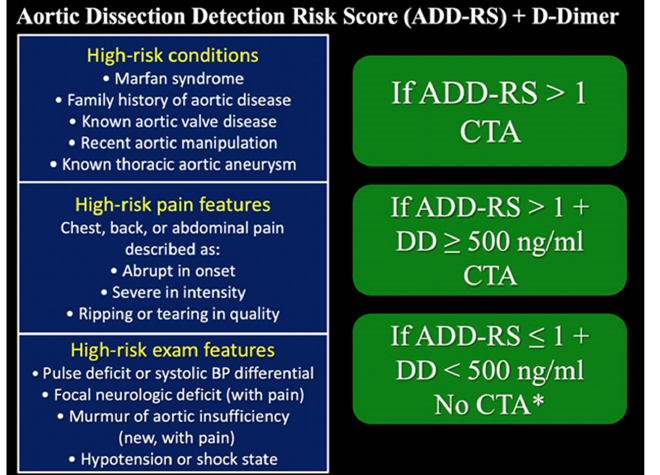
Figure 4. Pretest clinical probability assessment according to Aortic Dissection Detection Risk Score (ADD-RS) and D-Dimer (DD). ADD-RS score is based on 12 risk factors organized in three categories (0, low risk; 1, intermediate risk; 2-3. high risk). BP = blood pressure. *Caution in patients with early presentation ( ≤ 2 h) or long-lasting symptoms ( ≥ 1 week) [28]. Table 3. Complete list of morphologic features in AAS that need to be covered by imaging. The Ten Commandments in AAS.